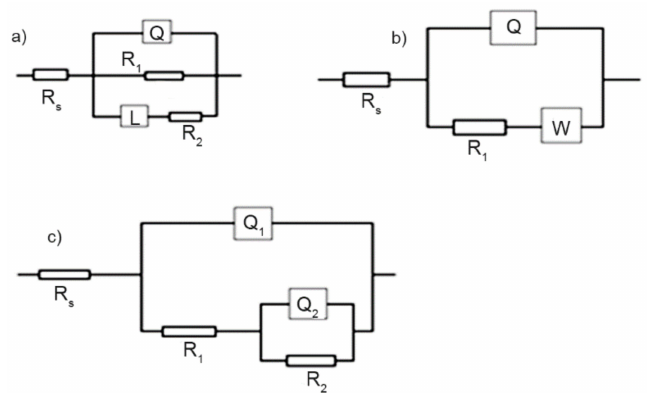
Figure 7. Equivalent circuits for alloy behavior: ( a ) initial sample, ( b ) after 7 days’ immersion; and ( c ) after 14 and 30 days immersion.